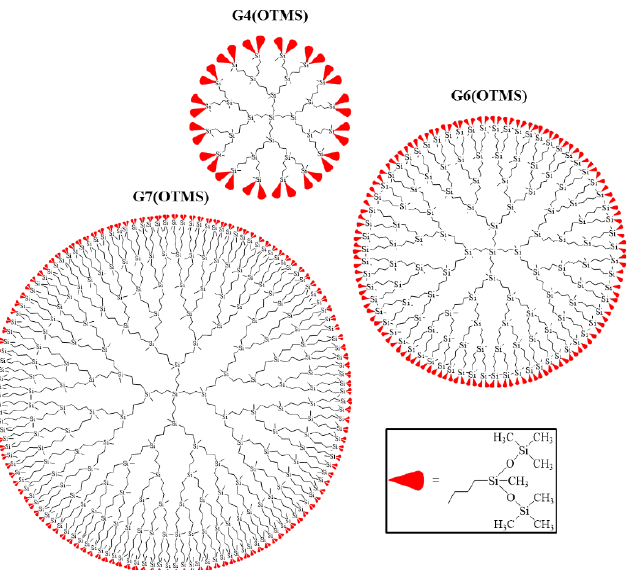
Figure 2. Homologous series of the obtained carbosilane dendrimers G4 (OTMS), G6 (OTMS), and G7 (OTMS) with a non-functional siloxane shell schematically shown by red.